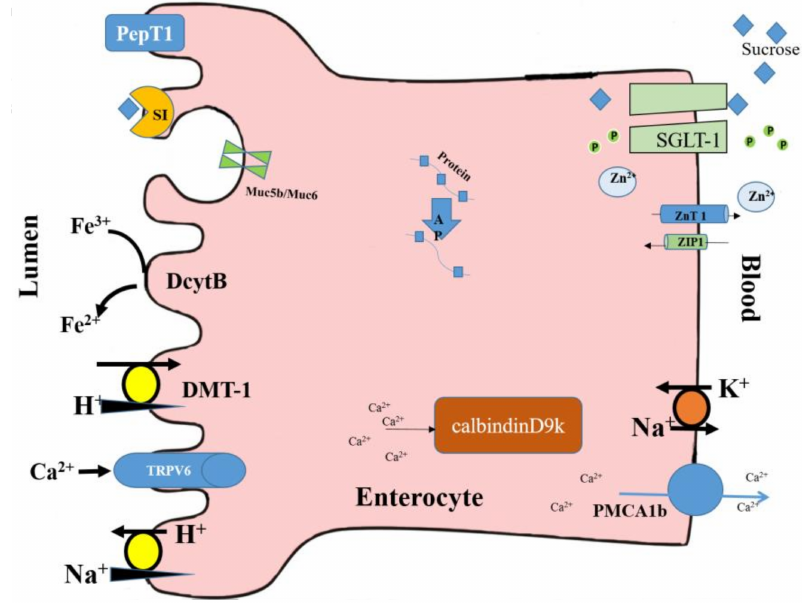
Figure 2. Schematic diagram of the discussed functional proteins located on the small intestinal enterocyte’s brush border and basolateral membranes. PepT1: peptide transporter 1; Dcyt B: duodenal cytochrome B; DMT-1: divalent metal transporter 1; AP: aminopeptidase; LAP: leucine